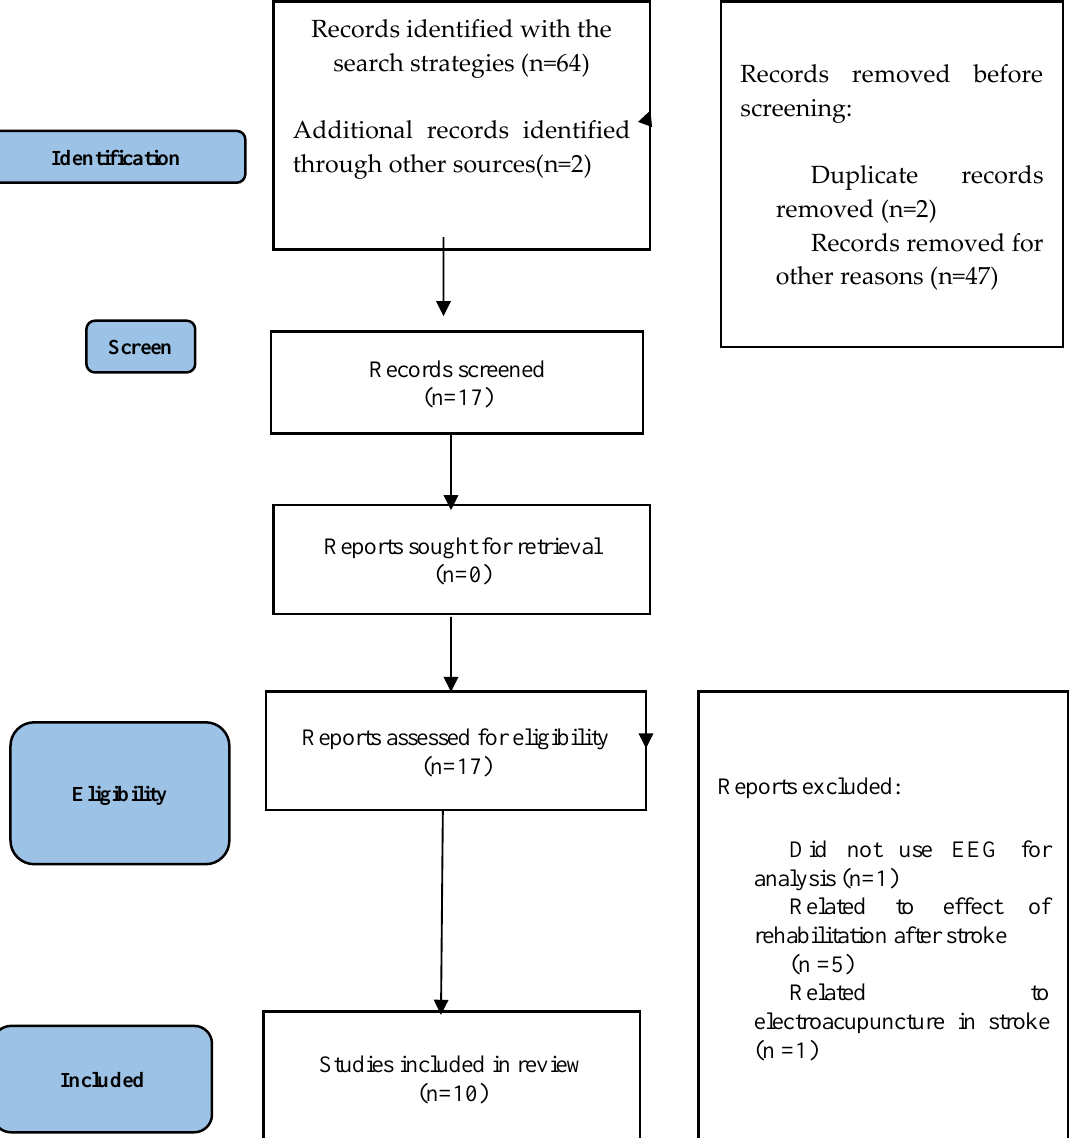
Figure 1. Preferred Reporting Items for Systematic reviews and Meta-Analyses (PRISMA) flowchart.